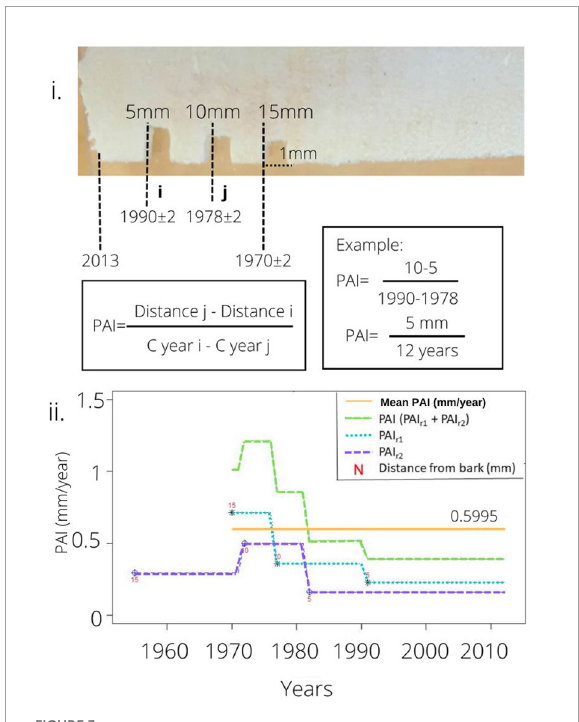
FIGURE3 Explanatory figure for how we used 14 C dating to estimate growth rates, expressed as periodic annual increment (PAI). (i) Photo showing the holocellulose (white) slab that is ∼ 1 mm thick; the portions removed for 14 C measurements at 5, 10, and 15 cm radial positions can be seen. The calendar age determined for each sample is shown, as well as the assumed year of tree cut at the bark, and the calculation of PAI is shown as an example. (ii) Graph showing how PAI varies with time for each interval dated with 14 C. The red number (N) indicates the distance (mm) from the dated point to the bark; PAI r1 - periodic annual increment of radius 1; PAI r2 - periodic annual increment of radius 2; PAI = The sum of the two radii over the entire period (assuming the sum of the two radii provides a measurement of the diameter increment; For this individual, PAI declined over the decades since the 1970s. Mean PAI is the periodic annual increment averaged out over the entire period represented in the outer 15 mm (usually representing multiple decades of growth).